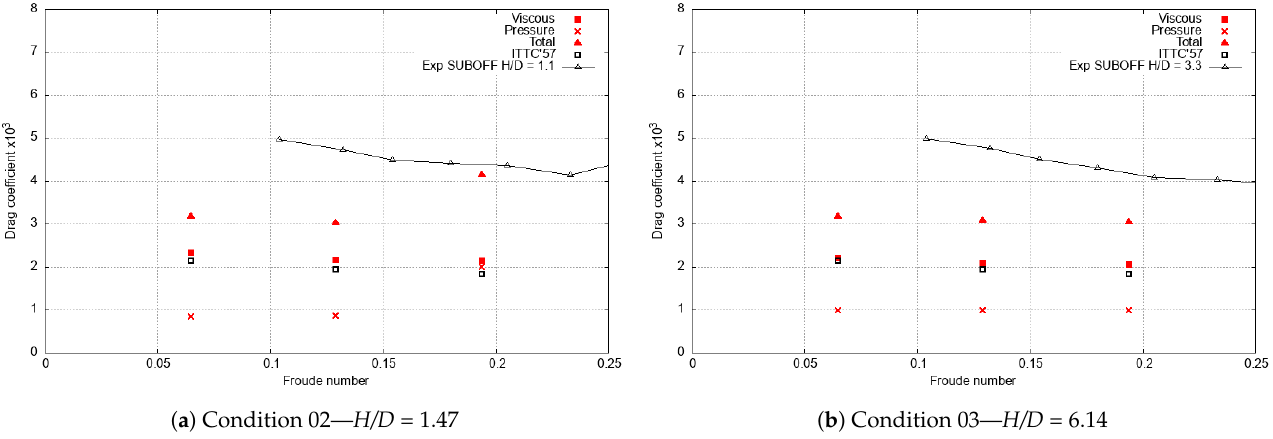
Figure 22. Drag coefficients vs Froude number for a Type 209/1300 submarine at condition 2 - periscope depth and 3 - deep Water